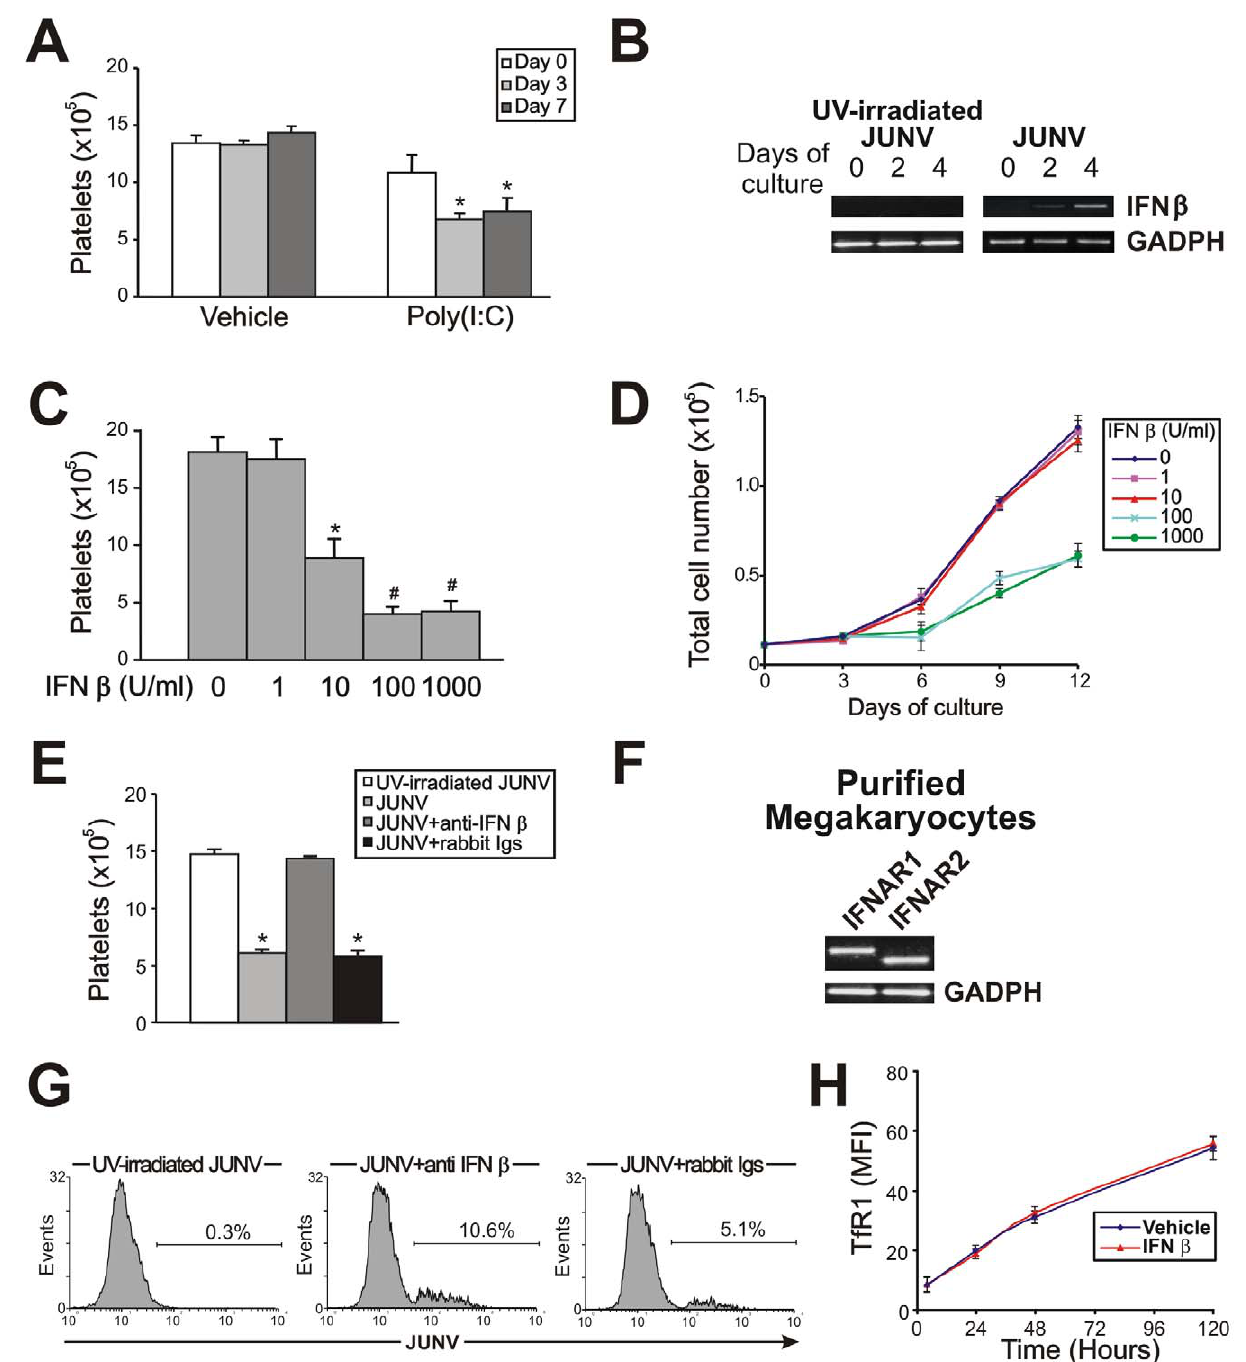
Figure 6. The role of the IFN b pathway in platelet production and JUNV infection. (A) CD34 + cells were treated with poly(I:C) (100 m g/ml) at the indicated days, stimulated with TPO, and Plt counts were determined at day 15 of the culture. The values represent the mean 6 SEM of four independent experiments, * p , 0.05 vs. vehicle (control). (B) IFN b mRNA levels in UV-irradiated JUNV- or JUNV-infected CD34 + cells were determined by RT-PCR at the indicated days of culture. The figure shows a representative experiment of three similar replicates. (C) CD34 + cells were treated with IFN b and stimulated with TPO. Plt counts were determined at day 15 of the culture. The values represent the mean 6 SEM of three independent experiments,* indicates p , 0.05 vs. no IFN b , # indicates p , 0.05 vs. IFN b (10 U/ml). (D) Total cell number was determined at the indicated days of culture by counting cells with a hemocytometer. Similar results were obtained in MTT assays. The values represent the mean 6 SEM of three independent experiments. (E) Anti-IFN b (1,000 neutralizing units) or an equal volume of rabbit Igs was added before CD34 + cell infection and Plt counts were determined at day 15. Values represent the mean 6 SEM of three independent experiments, * indicates p , 0.05 vs. UV-irradiated JUNV. (F) Type I IFN receptor subunit (IFNAR1 and 2) mRNAs were evaluated by RT-PCR in megakaryocyte precursors purified by immunomagnetic positive selection (99 6 1% of purity). The figure shows a representative experiment of three similar replicates. (G) CD34 + cells were infected with JUNV and 1000 neutralizing units of anti-IFN b or an equal volume of rabbit Igs were added before TPO stimulation. Viral antigens were detected by flow cytometry. The figure shows a representative experiment of two similar replicates. (H) The kinetics of TfR1 expression in the presence or absence (vehicle) of IFN b (10 U/ml) in CD34 + cells stimulated with TPO were determined by flow cytometry.